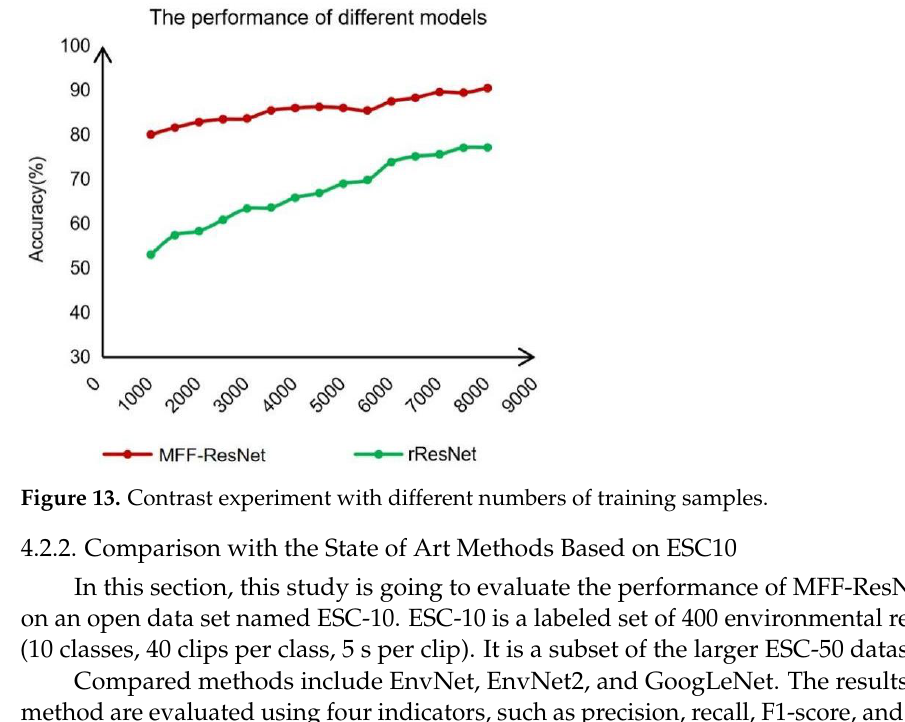
Table 3. Comparison of algorithms based on ESC10 datasets (the best performance is underlined).